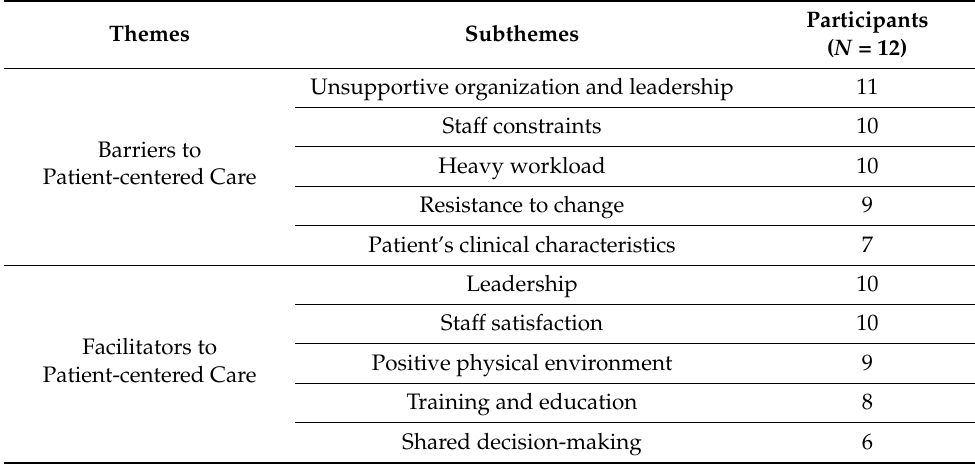
Table 2. Barriers and facilitators to patient-centered